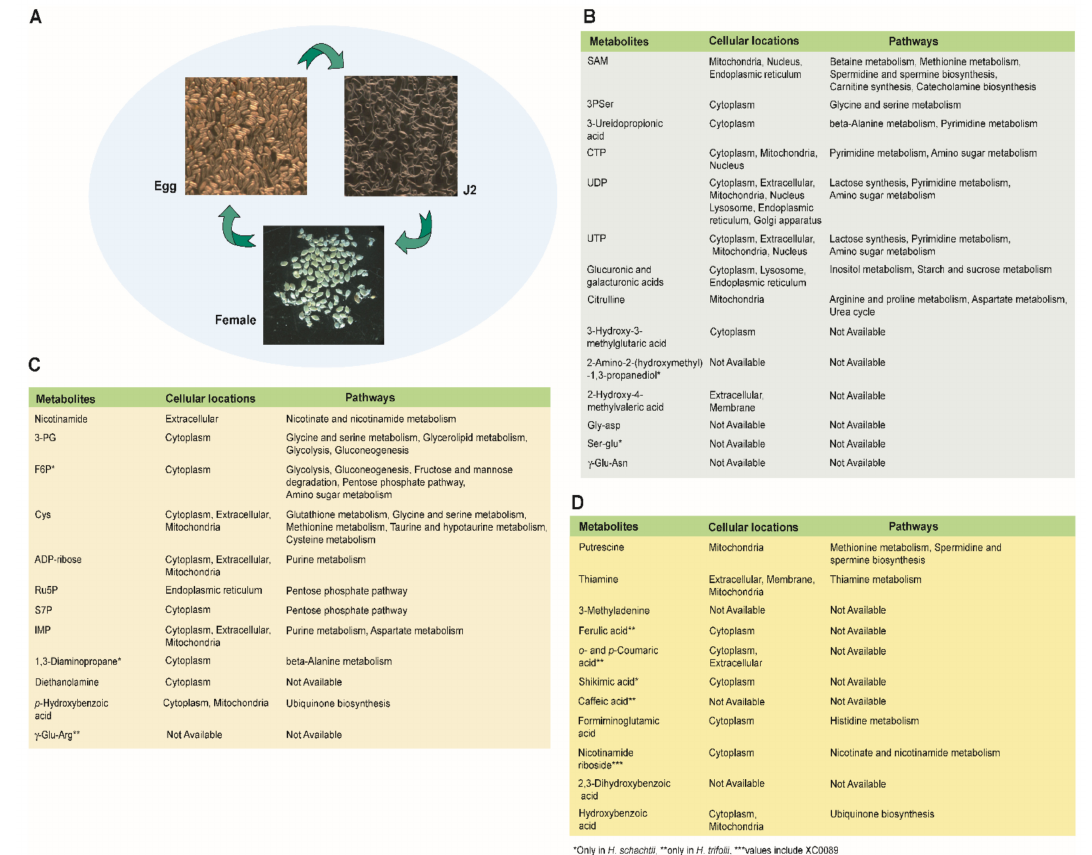
Figure 5. Stage-specific metabolites in H. schachtii and H. trifolii with their functions and biosynthetic pathways. Photographs of nematodes in the egg, J2, and female stages ( A ); metabolites highly detected at only the egg stage ( B ); J2 stage ( C ); and female stage ( D ). Cellular locations and pathways as defined in